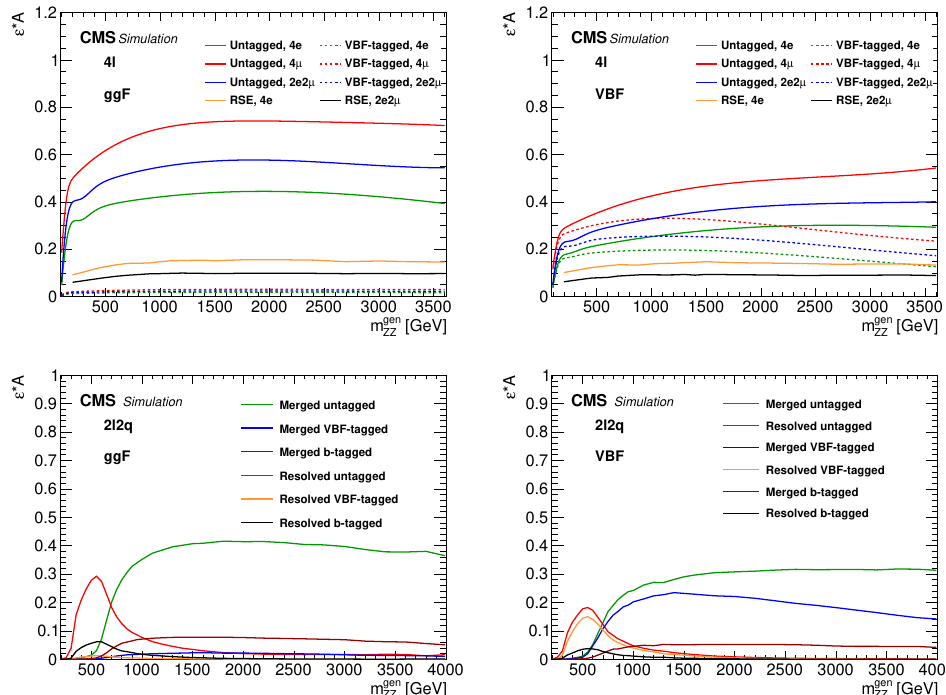
Figure 7 . The product of e(cid:14)ciency and acceptance for signal events to pass the X ! ZZ ! 4 ‘ (upper plots) and X ! ZZ ! 2 ‘ 2q (lower plots) selection as a function of the generated mass m Gen from ggF (left) and VBF (right) production